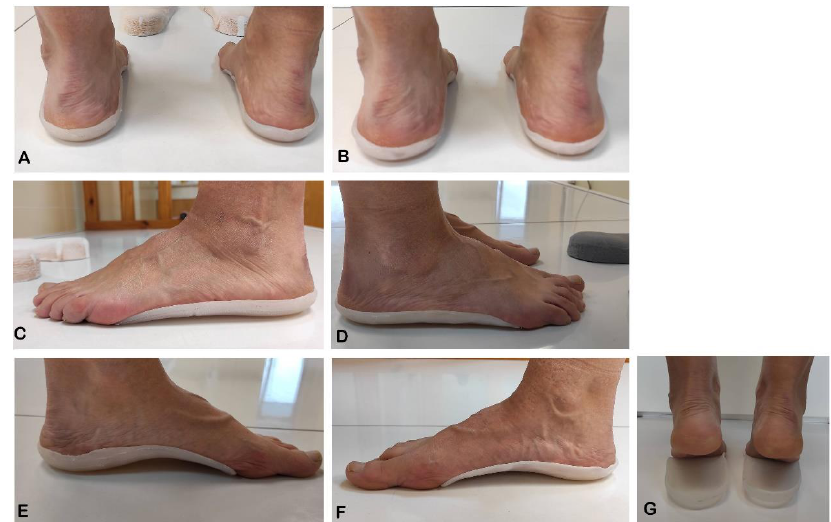
Figure 4. Fitting the orthoses obtained using the traditional and digital method. A and B : Rear view of the orthoses obtained through the traditional and digital method, respectively. C and D : Lateral view of the orthoses obtained through the traditional and digital method, respectively. E and F : Medial view of the orthoses obtained through the traditional and digital method, respectively. G : Rear view of participant on tiptoe to show the retrocapital fit of the orthosis.